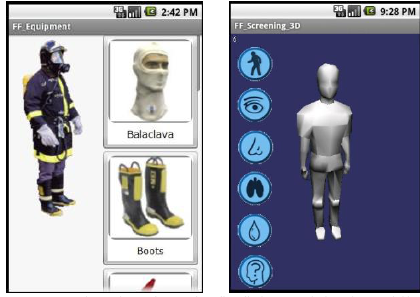
Figure 10. 2D and 3D interfaces for firefighter training in mobile phone.